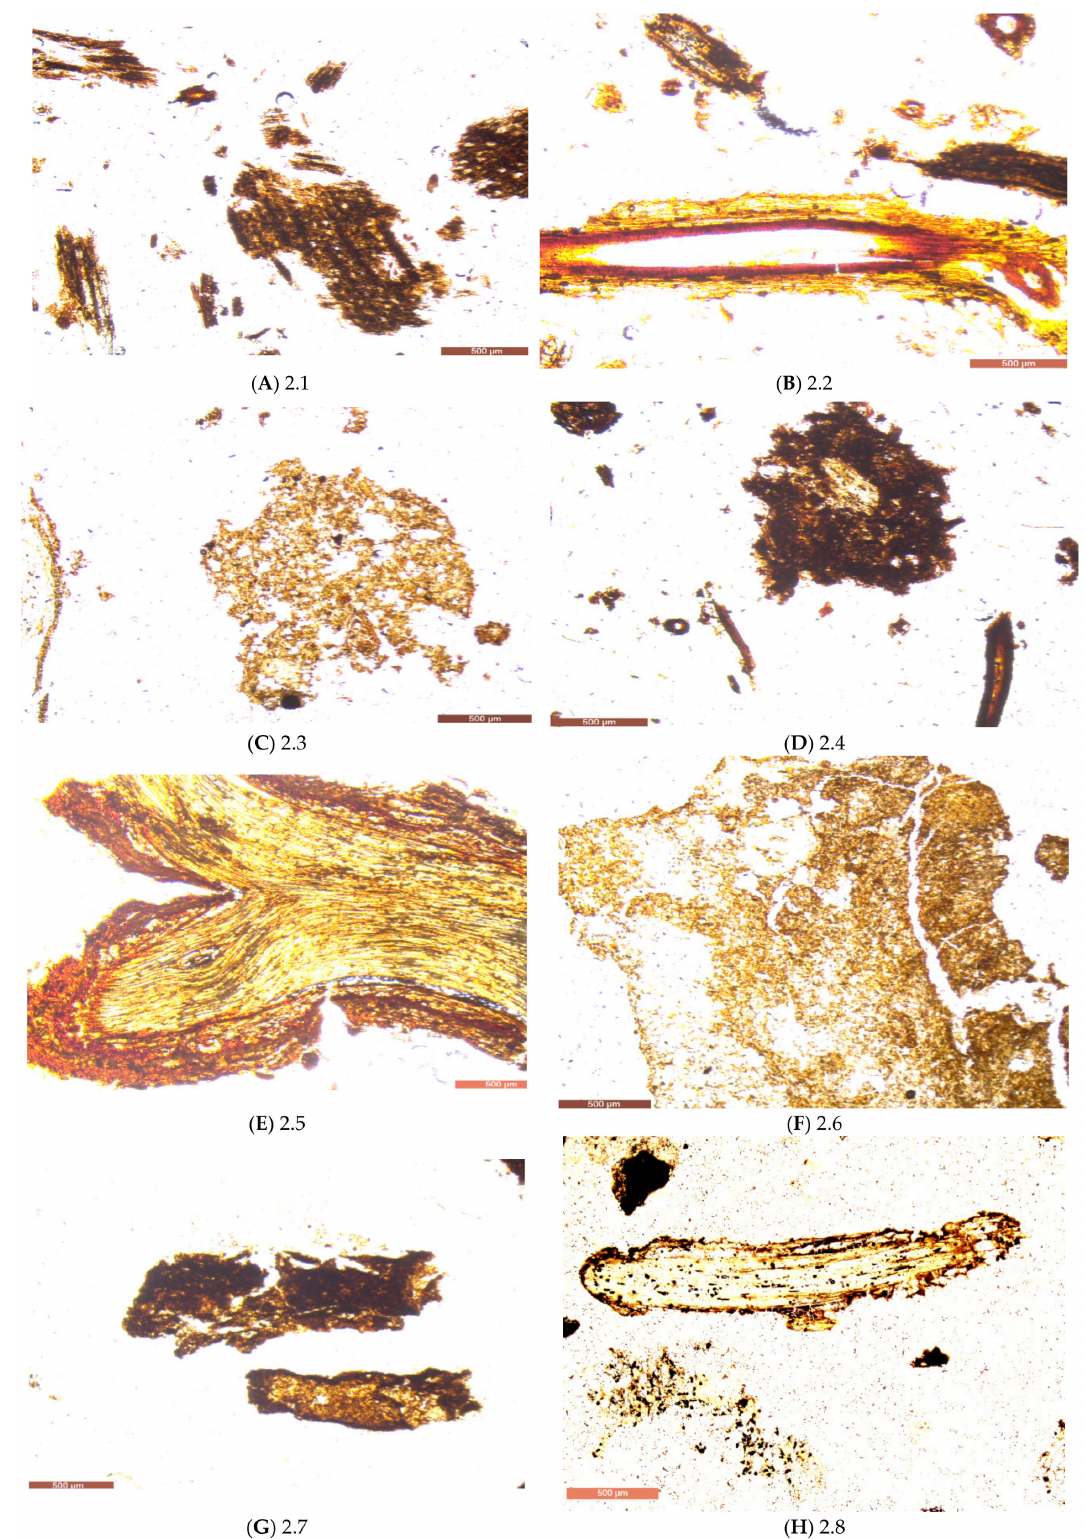
Figure 4. Organic matter morphology. Sample set 2. Transmitted light. ( A ) 2.1, ( B ) 2.2, ( C ) 2.3, ( D ) 2.4, ( E ) 2.5, ( F ) 2.6, ( G ) 2.7, ( H ) 2.8. In other words, suspended soils resemble upper peats to some extent. The question arises: how are they structured into vertical clusters on the tree trunk and able to